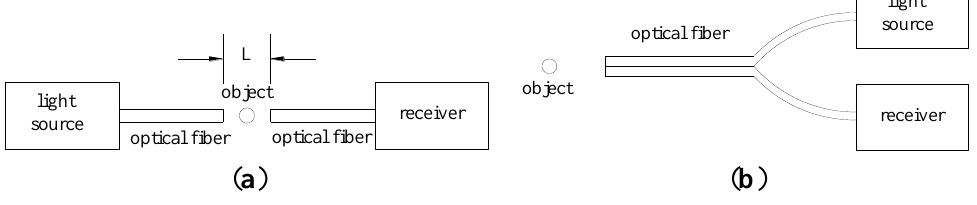
Figure 1. Two different types of optic fiber probes [19] ( a ) transmission-type; ( b )